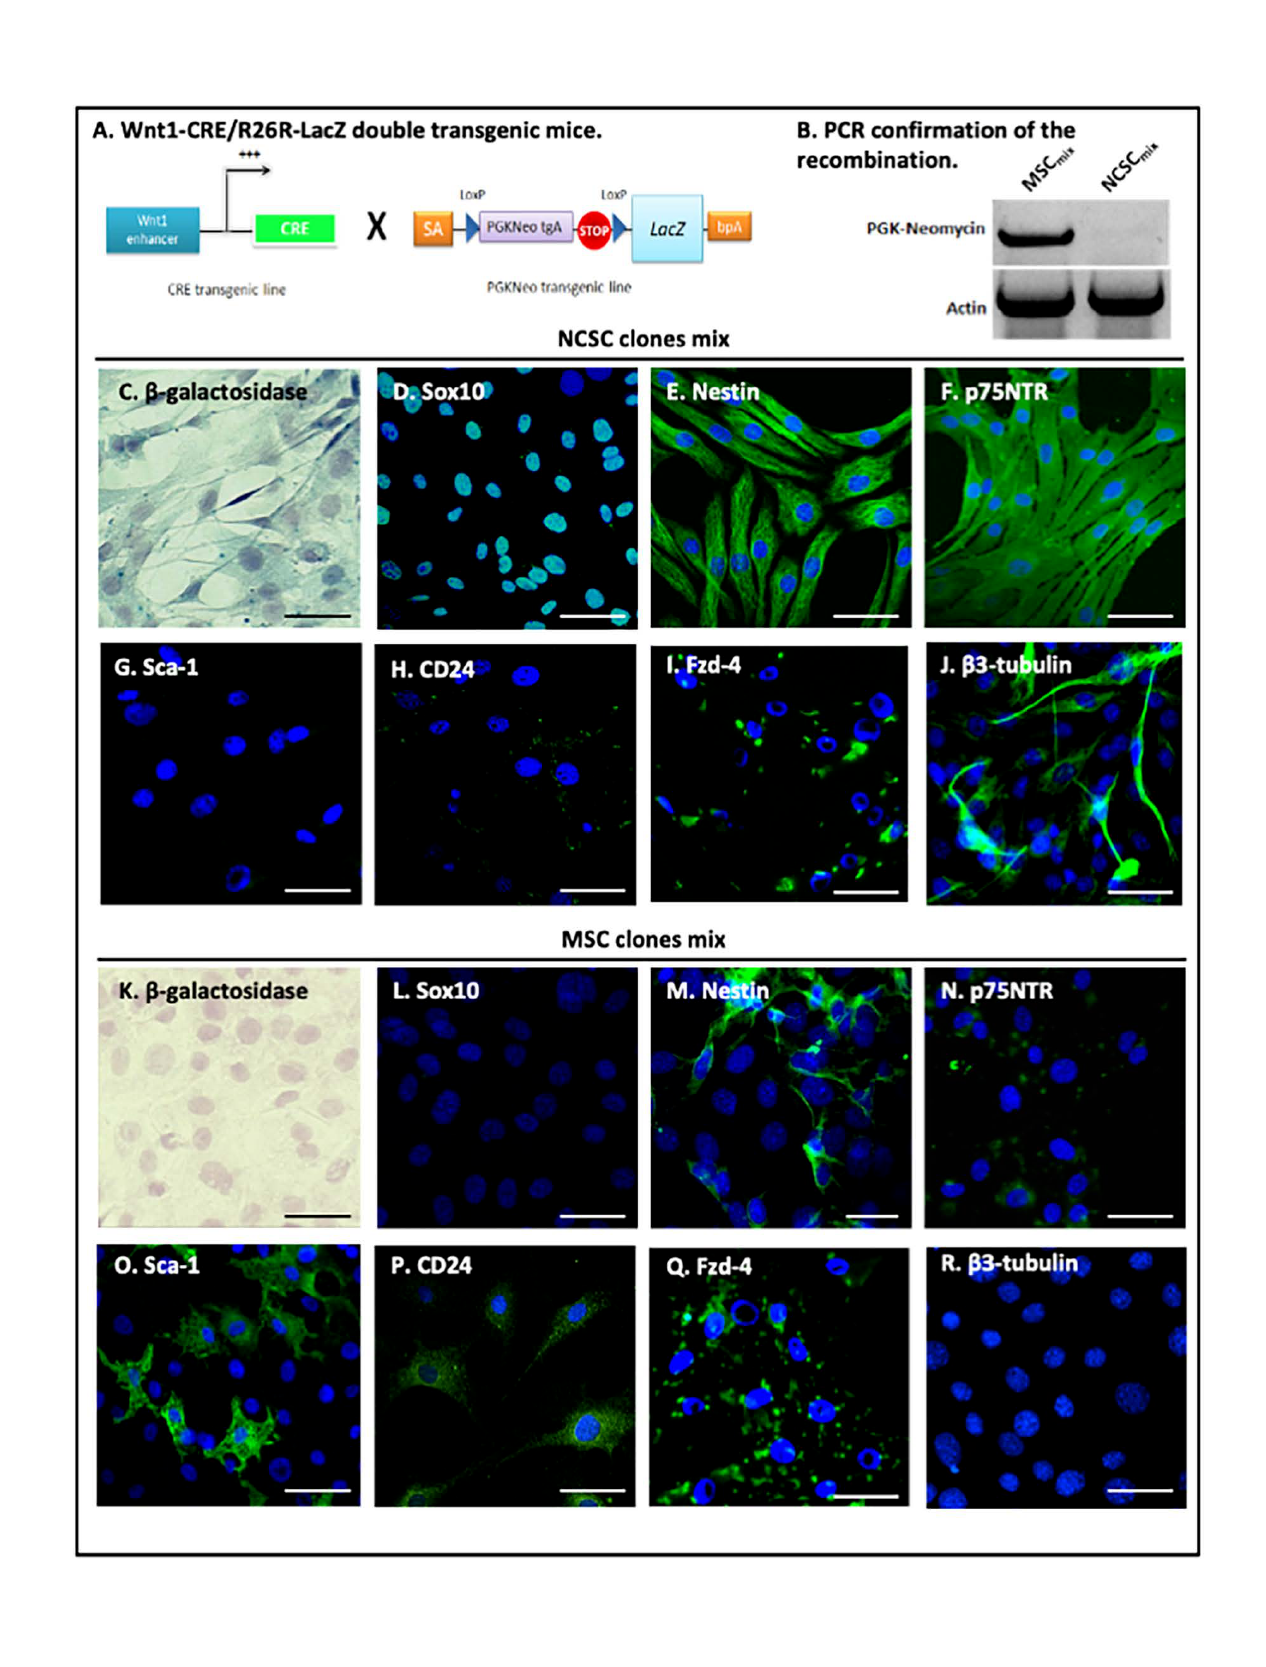
Figure 1. In vitro characterization of NCSC mix and MSC mix, isolated from adult Wnt1-Cre/R26R-LacZ mouse bone marrow. BMSC were harvested from double-transgenic Wnt1-CRE/R26R-LacZ mouse bone marrow (A). Amplification of the PGK-Neo cassette confirmed that NCSC mix